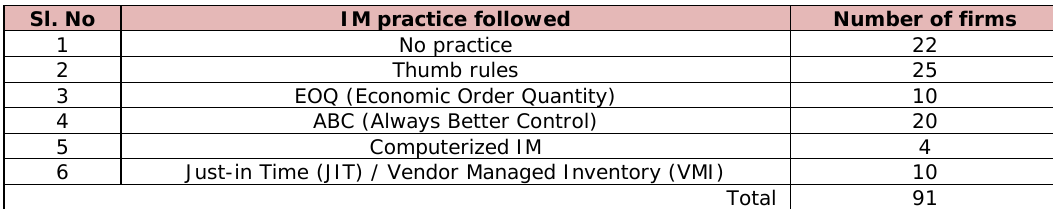
Table 1. “IM practices followed in